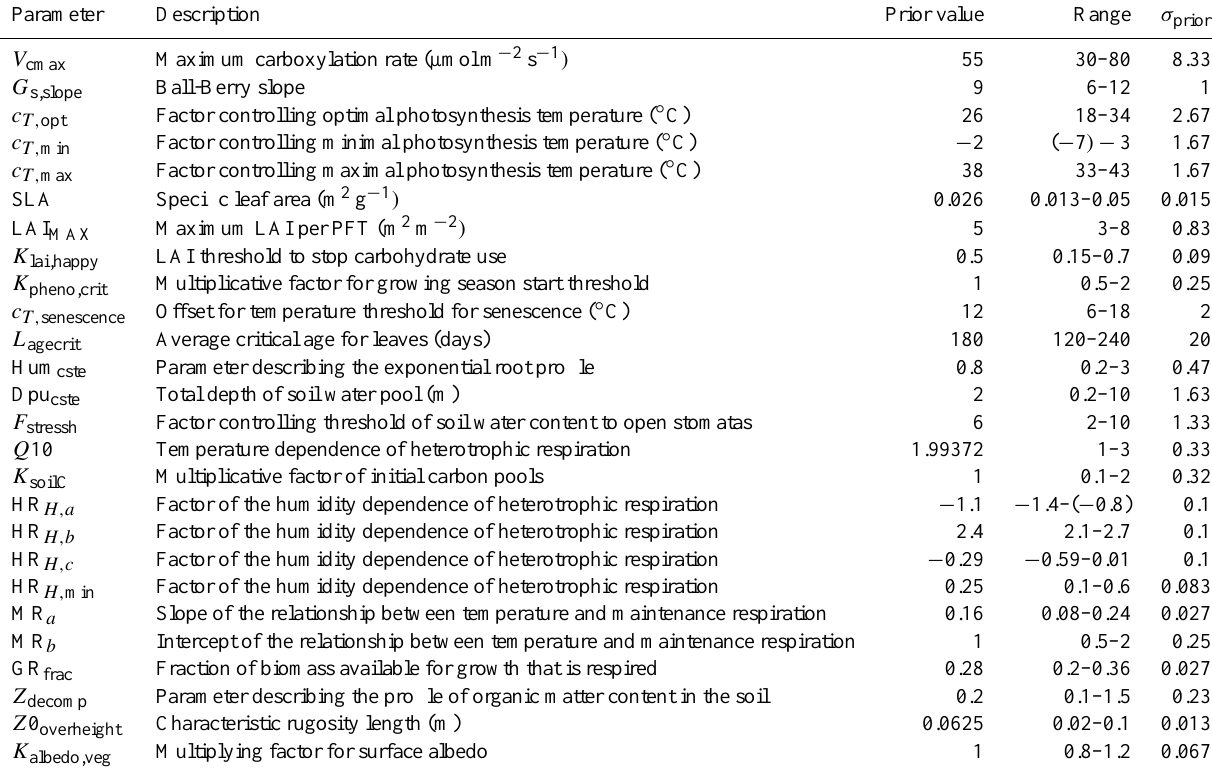
Table B1. Parameters of the state vector x , with their prior value, variation range and uncertainty.